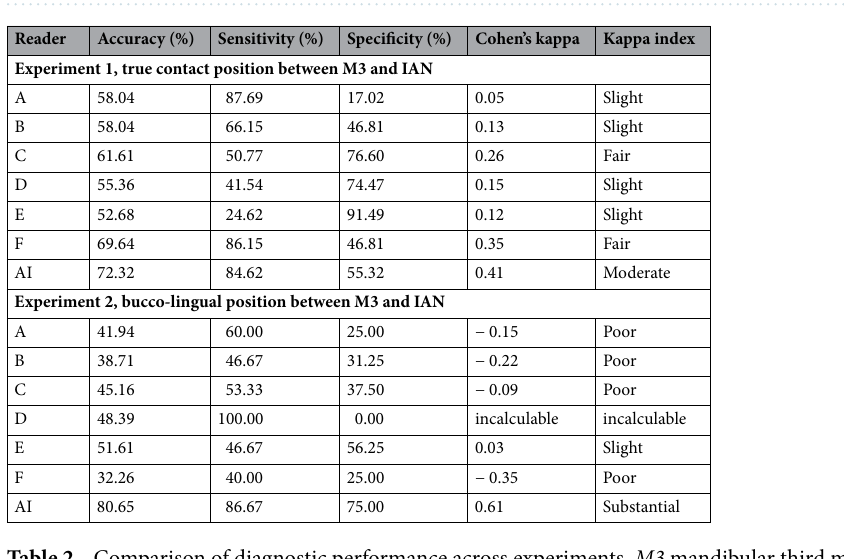
Table 2. Comparison of diagnostic performance across experiments. M3 mandibular third molar, IAN inferior alveolar nerve.